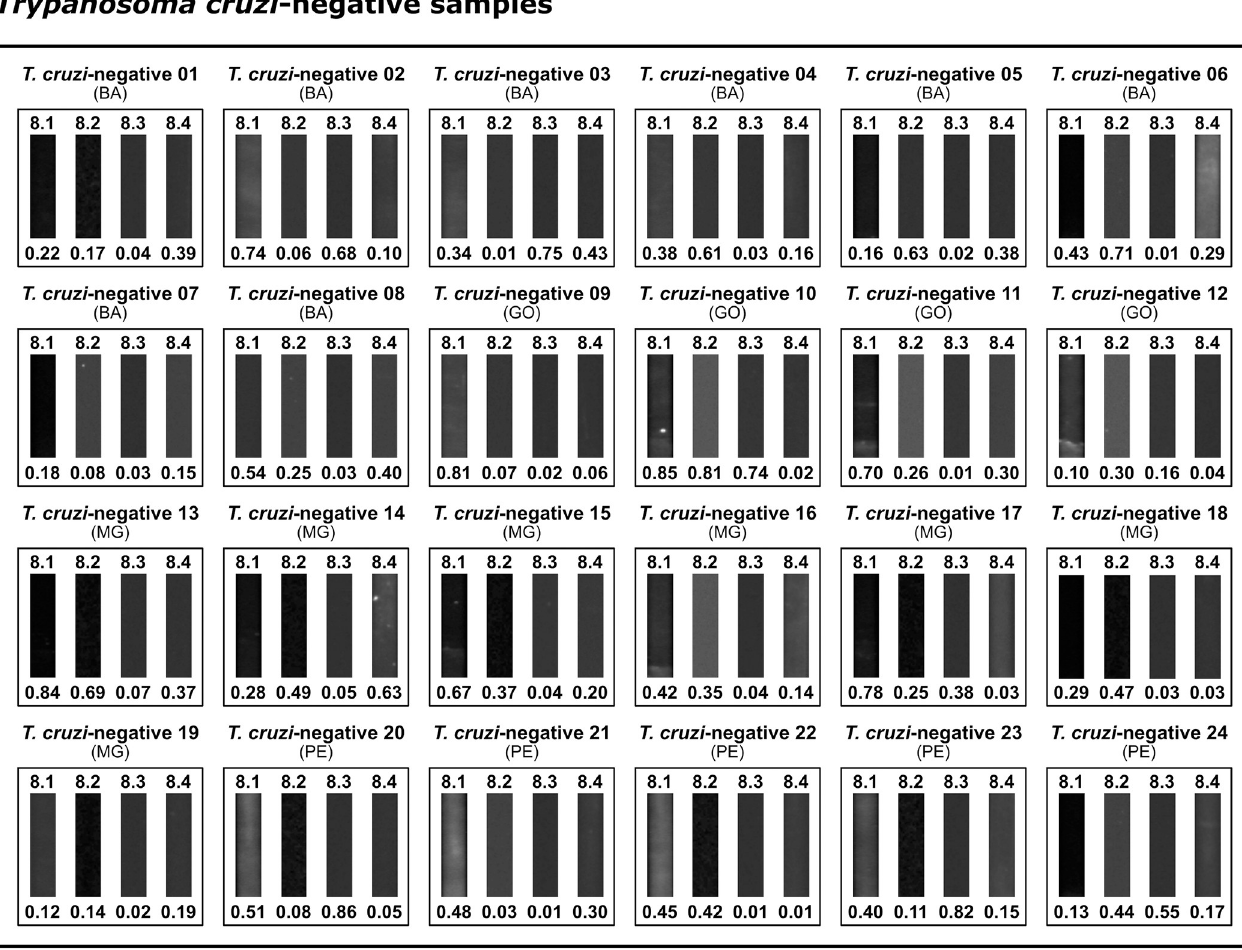
Fig 4. Photographic images of nitrocellulose test strips result from Trypanosoma cruzi -negative samples. Relative band intensity (RBI) values respective to each IBMP antigen are shown below the images pertaining to each sample. Abbreviations: AL (Alagoas); AP (Amapa´); BA (Bahia); GO (Goia´s); MG (Minas Gerais); PE